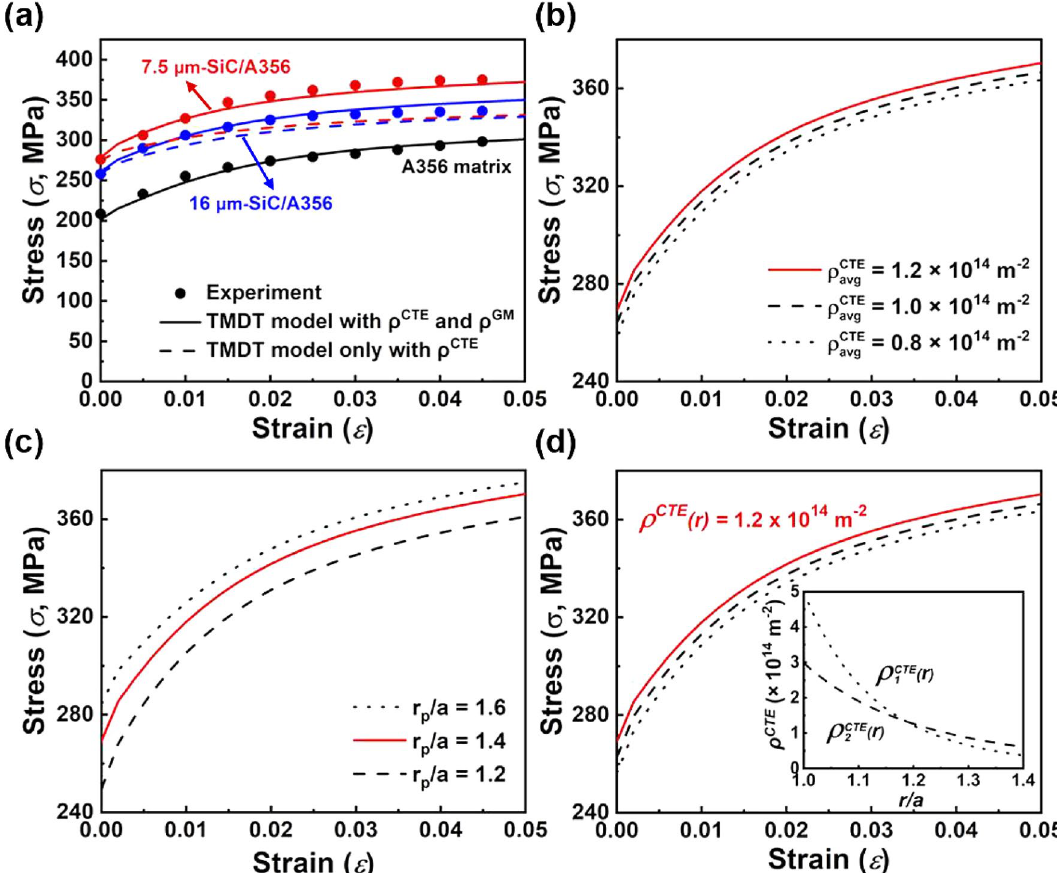
Figure 6. The mechanical stress–strain responses calculated by the VPSC-TMDT model with thermal mismatch dislocations. ( a ) The calculated results by the VPSC-TMDT model well correspond to the experimental data of the SiC/A356 composites. ( b ) Mechanical responses with various average dislocation density ( ρ CTE avg ). ( c ) Mechanical responses with various ranges of dislocation distributions. ( d ) Mechanical responses with various heterogeneous dislocation